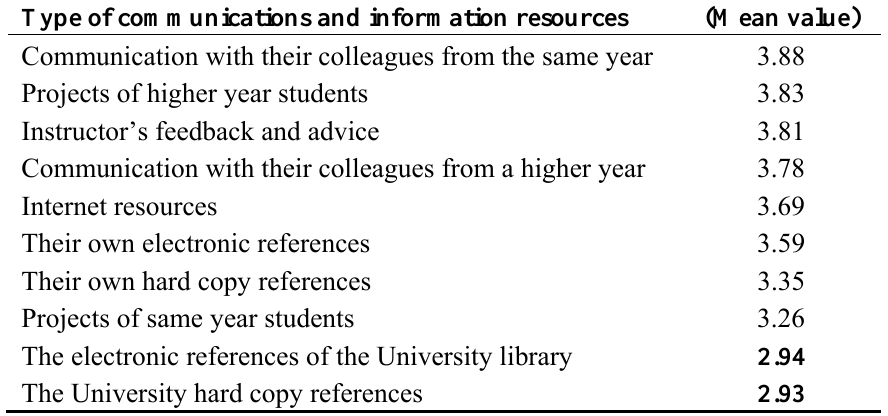
Table 2. Usefulness of the types of communication and resources in producing innovative projects ( scale: 1: not useful to 5: very useful